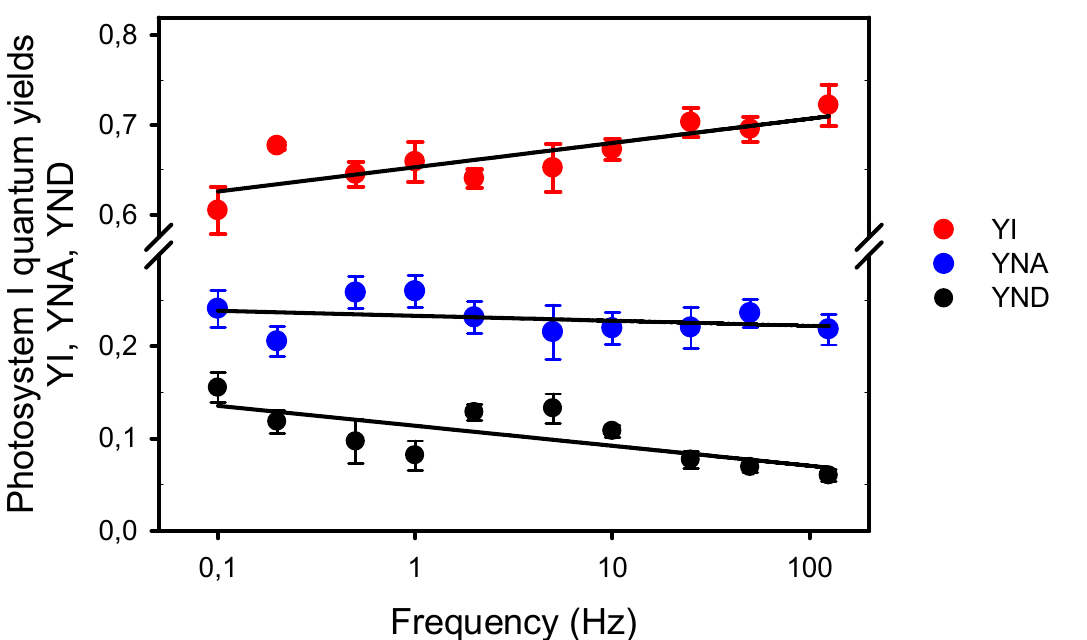
Figure 5. Complementary quantum yields in photosystem I measured under different frequencies of pulsed lights: The quantum yield of photochemical energy conversion, YI; and the quantum yields of nonphotochemical energy dissipation due to donor side limitation, YND, and acceptor side limitation, YNA. The slope a of the logarithmic regression (a * ln(Yx) + b) for YI is 0.012 (R 2 = 0.670, S.S.E. = 0.003, p = 0.0038), −0.002 for YNA (R 2 = 0.095, S.S.E. = 0.003, p = 0.3851), and −0.009 for YND (R 2 = 0.525, S.S.E. = 0.004, p = 0.0178). Note the broken y -axis between 0.3 and 0.575.